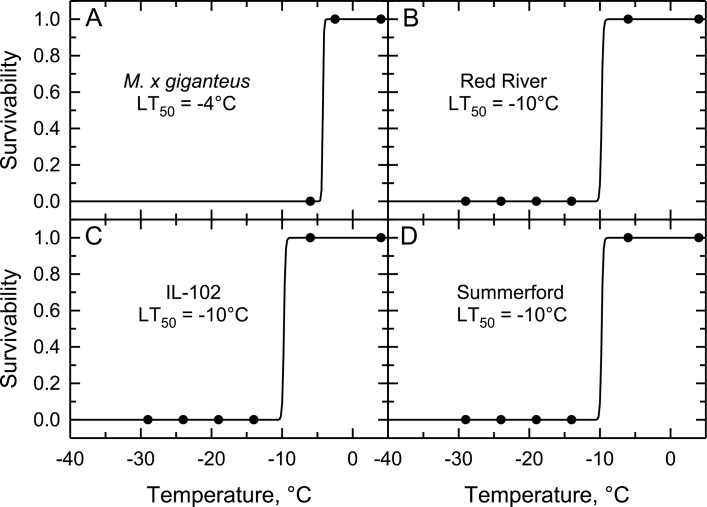
The relationship between exposure temperature and the % of rhizome survival for the spring harvest on 28 April 2014. (A) Results from Miscanthus × giganteus. (B–D) Results from the ‘Red River’, ‘IL-102’ and ‘Summerford’ accessions of Spartina pectinata. Mean ±SE, n=12 rhizomes per treatment temperature. The estimated temperatures corresponding to 50% rhizome mortality (LT50) are shown in each panel. The trend line is the predicted relationship using a generalized linear model fitted to the data. See online Supplementary Table S3 for means.